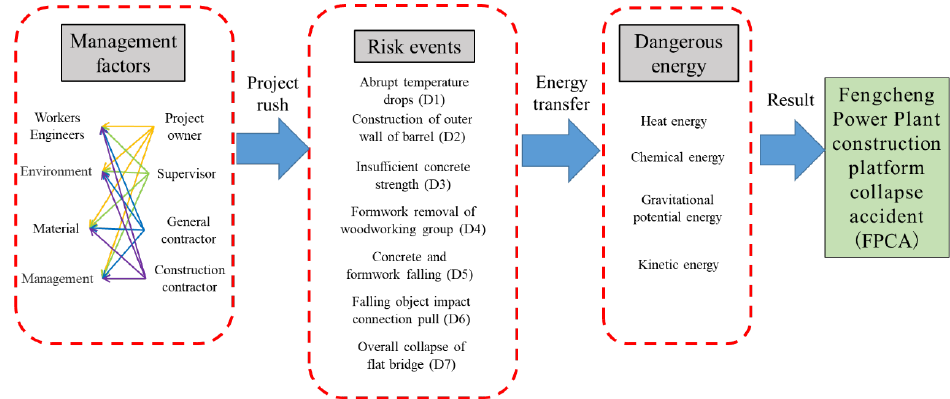
Figure 8. Flowchart of the project management and energy transfer changes.